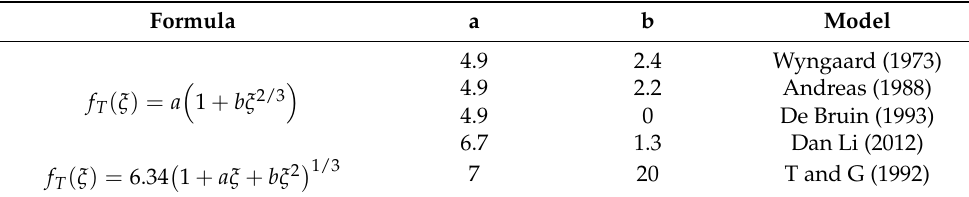
Table 2. Expressions for similarity functions under stable conditions ( ξ > 0 ).